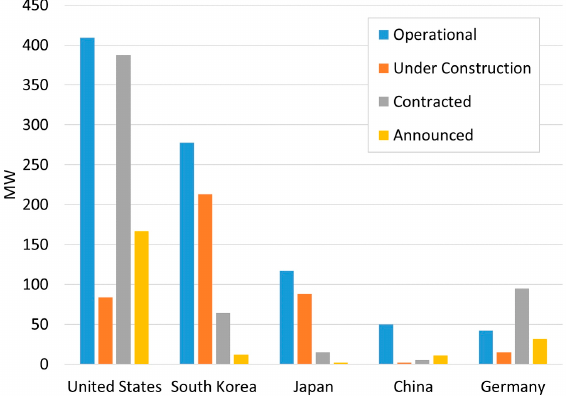
Figure 4. Operational and planned battery storage by country (created using data obtained from [7,26]).